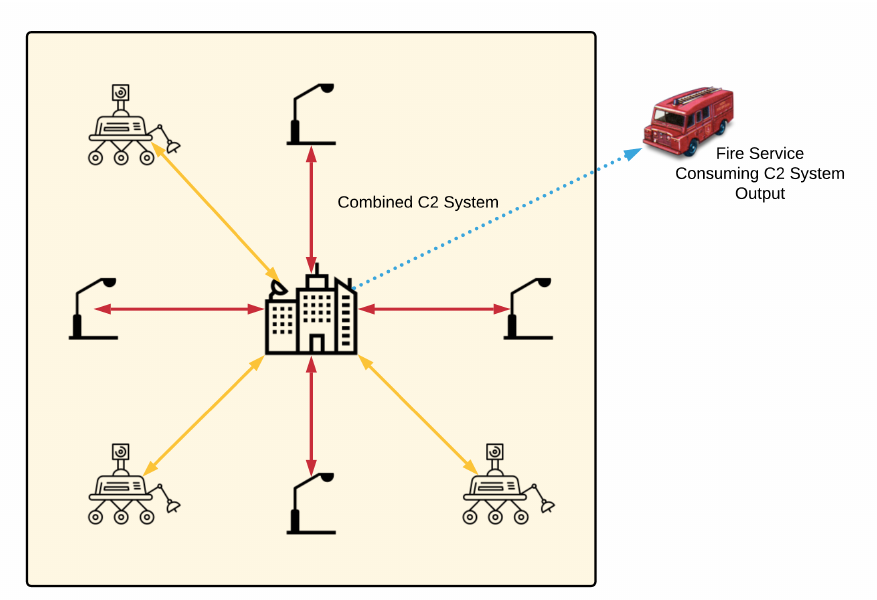
Figure 2. An example of a mobile system joining its sensors to a fixed system during an emer- gency